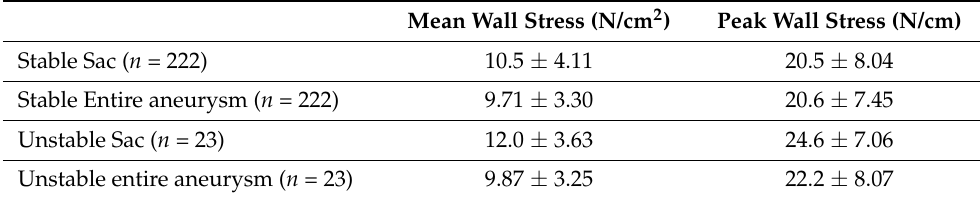
Table 1. MWS and PWS reported for both geometric regions analyzed and between stable and unstable AAA